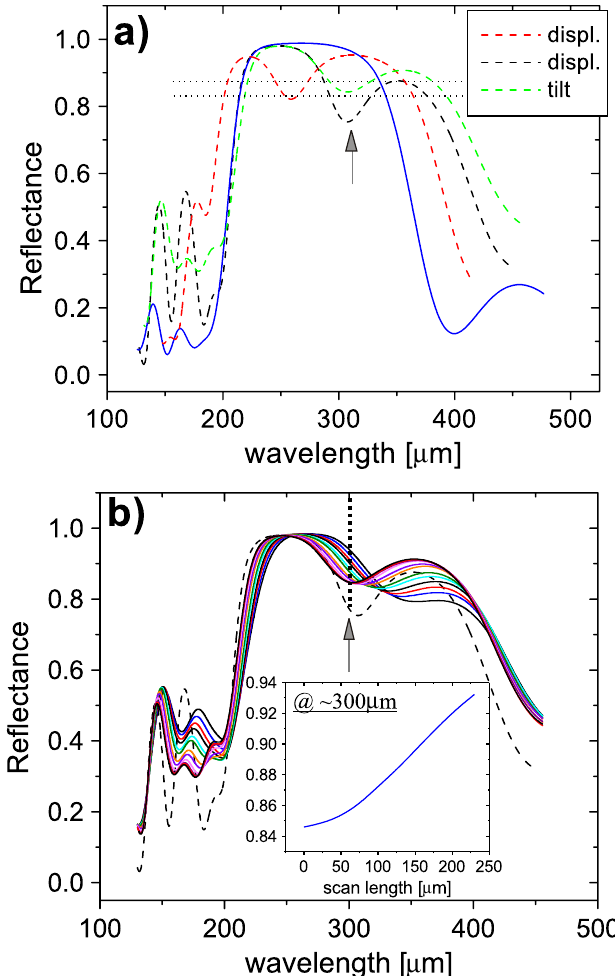
FIG. 7. (Color) (a) Measured transmission peaks created by displacing and subsequent tilting (arrow) the outermost quartz wafer ( 3 þ 1 ). Fine-tuning of the outcoupling ratio is demon- strated in (b) at around 300 (cid:6) m by employing a HR stepper motor driven actuator. Inset: reflectance changes obtained at a fixed wavelength (dashed line) of (cid:1) 300 (cid:6) m as a function of the scan length.